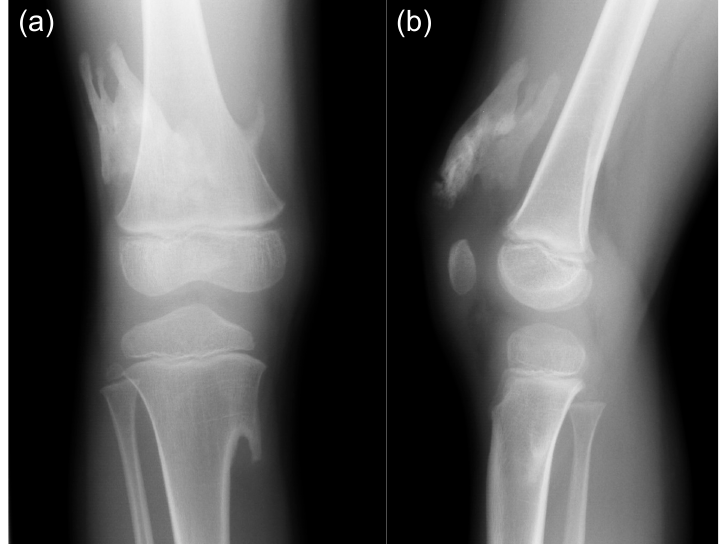
Figure 8. Anteroposterior ( a ) and lateral ( b ) knee radiographs of the FOP boy at the age of 5 years showing heterotopic ossification at the distal thigh and osteochondroma-like lesions of the distal femur and proximal tibia.